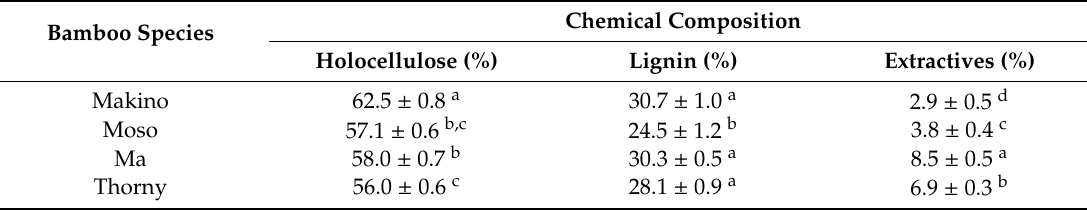
Table 2. Chemical compositions of various bamboo fibers (BFs).